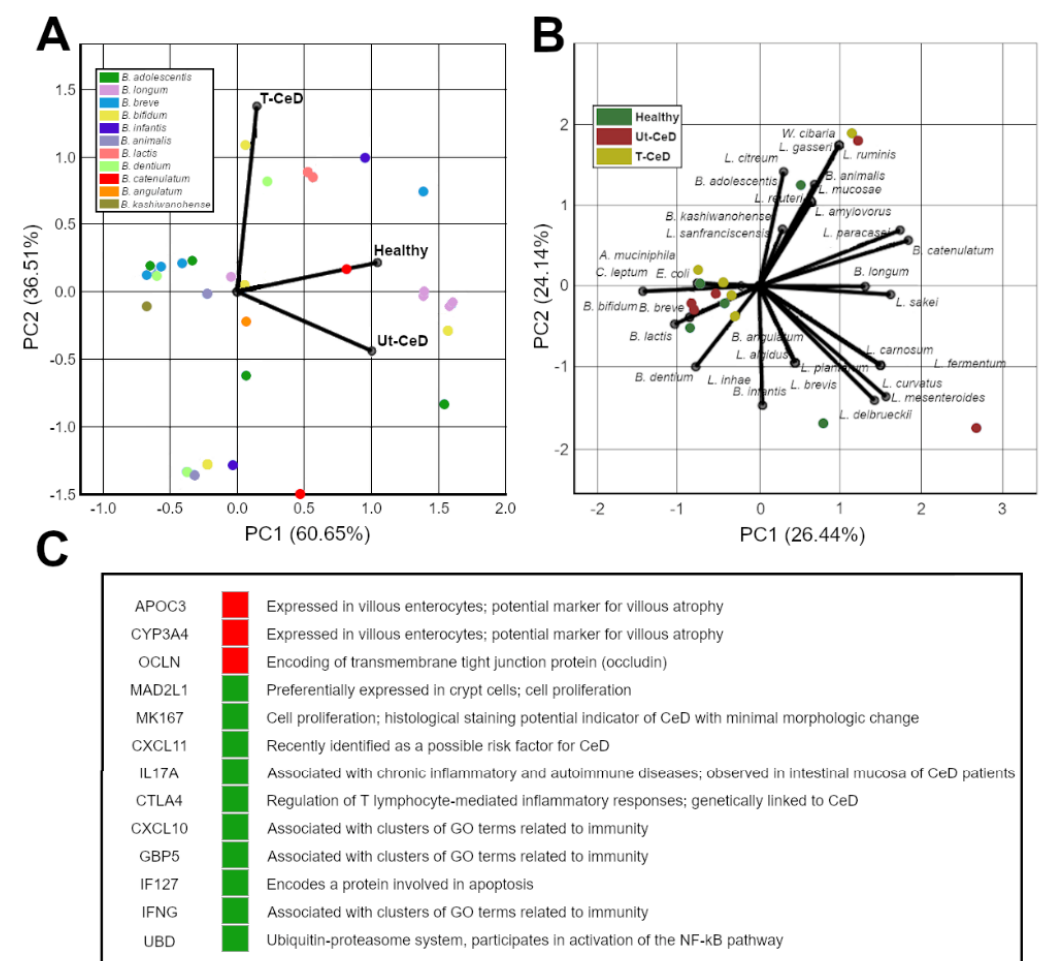
Figure 7. A categorical principal components analysis detailing ( A ) the separation of gut microbiome profiles of healthy, untreated (Ut-CeD) and treated (T-Ced) subjects, ( B ) the influence of specific gut microbial species of those subjects, and ( C ) the profiling of the gut’s gene expression extracted from the intestinal biopsies of coeliac disease (CeD) patients.